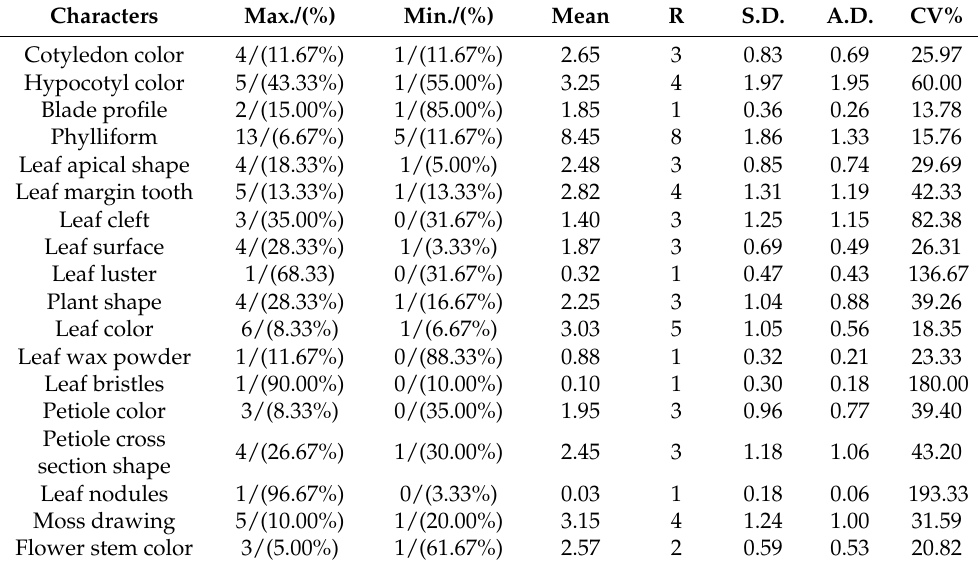
Table 5. Analysis on qualitative characters of 60 mustard resources.